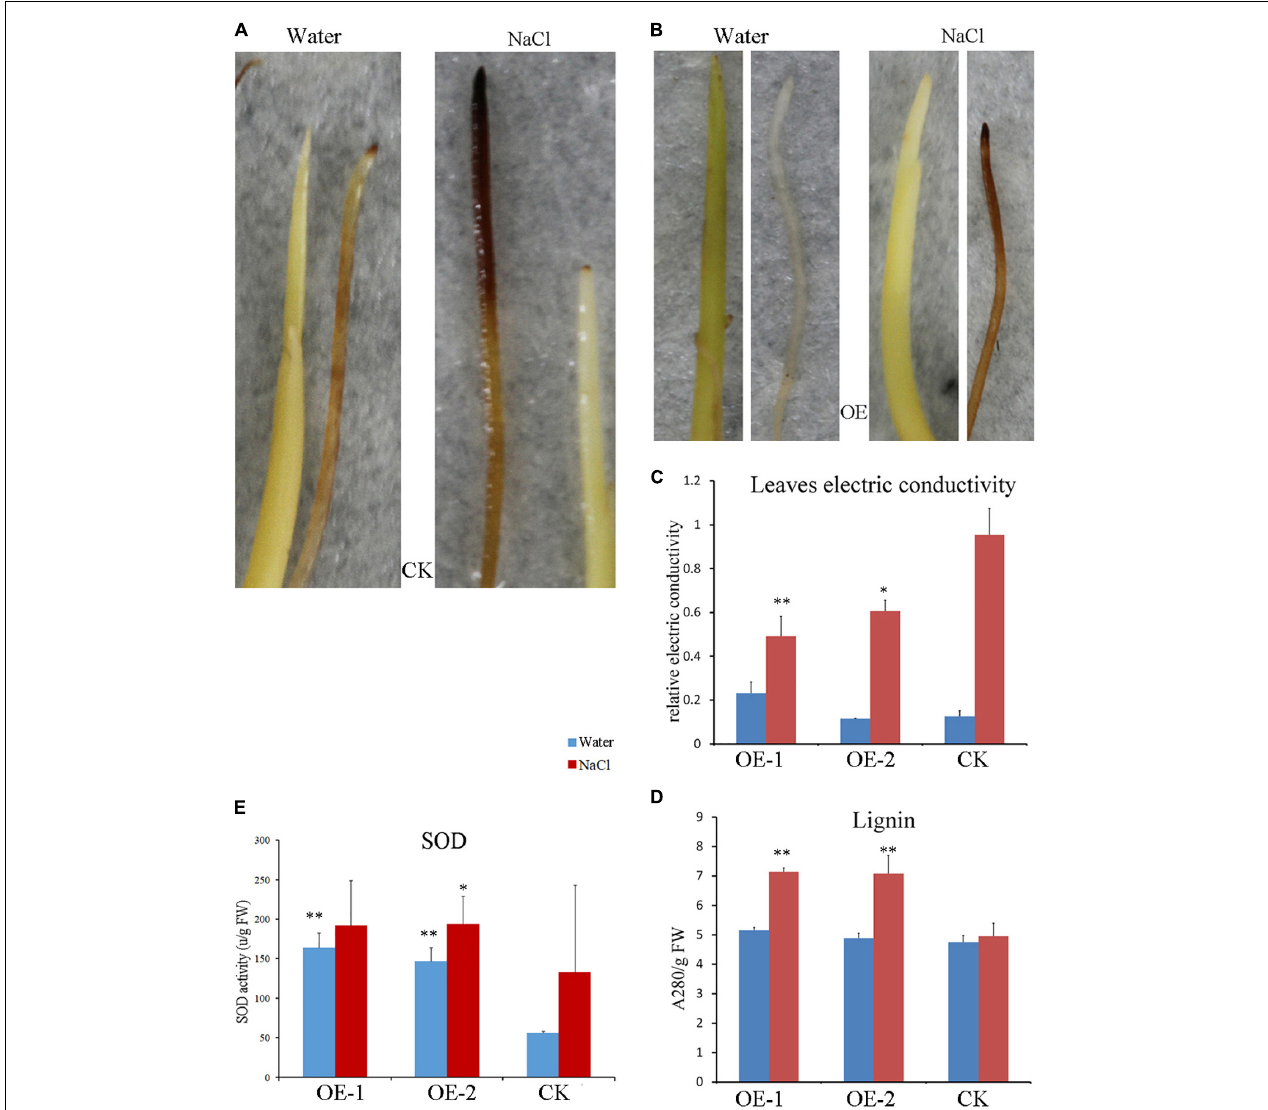
FIGURE 8 | Reactive oxygen species (ROS) level and lignin assay of PpBURP2 transgenic plants. (A) Images of the WT (CK) root and bud infiltrated with DAB under water and 100 mM NaCl treatments during seed germination. (B) Images of PpBURP2 -OE1 (OE) root and bud infiltrated with 3,3 (cid:48) -diaminobenzidine (DAB) under water and 100 mM NaCl treatments during seed germination. (C) Leaf electric conductivity after 100 mM NaCl and water treatments. (D) Lignin content in leaf after 100 mM NaCl and water treatments. (E) Superoxide dismutase (SOD) activity in leaf after 100 mM NaCl and water treatments. OE-1 and OE-2 indicate transgenic PpBURP2 lines 1 and 2, and CK indicates the WT. The error bars indicate SEs based on three replicates. The t -test was performed between OE and CK in same color columns. ∗ p < 0.05 and ∗∗ p <